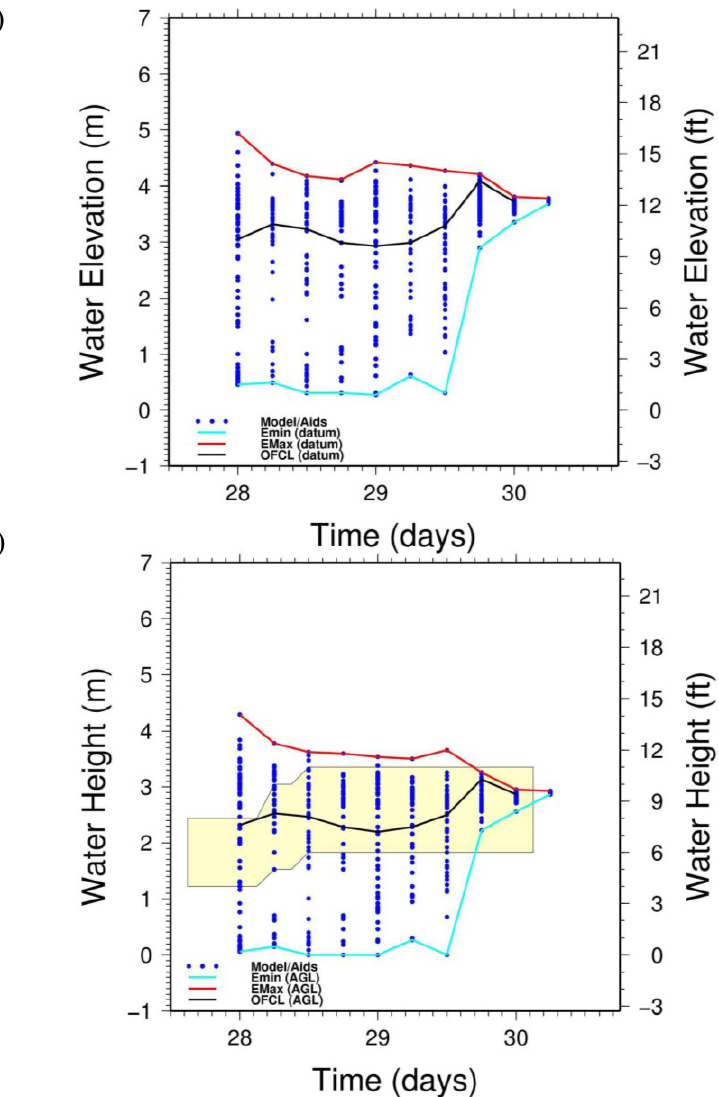
Figure 8. Trend of ( a ) maximum water elevation in the entire SLOSH basin relative to the NAVD88 vertical datum, and ( b ) the water height above ground level (AGL) for all ensemble members in the SLOSH storm surge-only simulations. The time in days (horizontal axis) denotes the initial time (UTC) of the model forecasts. The yellow box depicts the range of water levels issued in real-time by NHC in the forecast